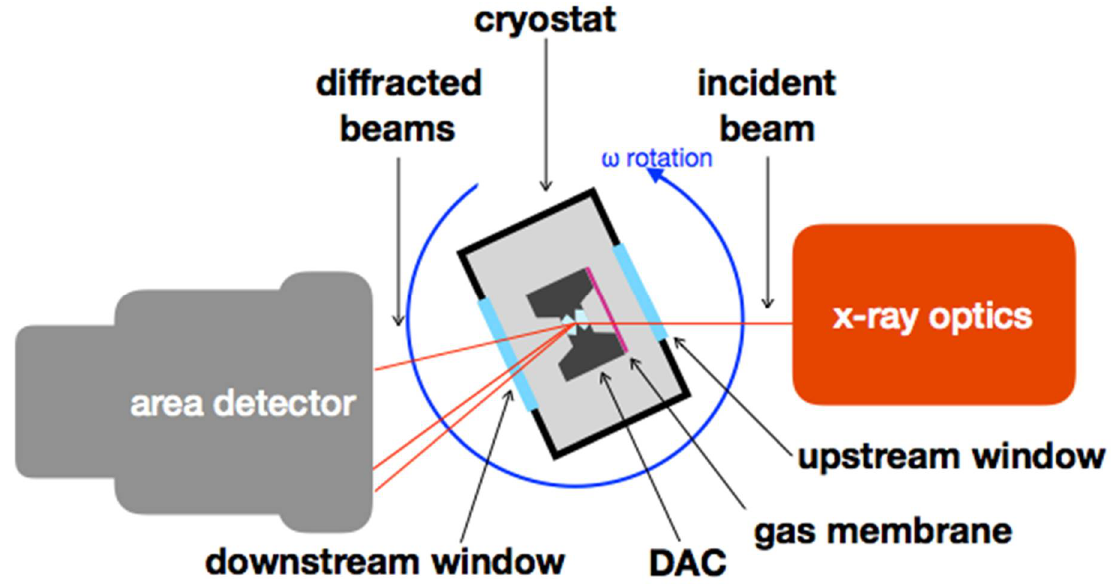
Figure 2. Schematic representation of the high-pressure low-temperature setup at beamline 16ID-B of the APS, ANL.